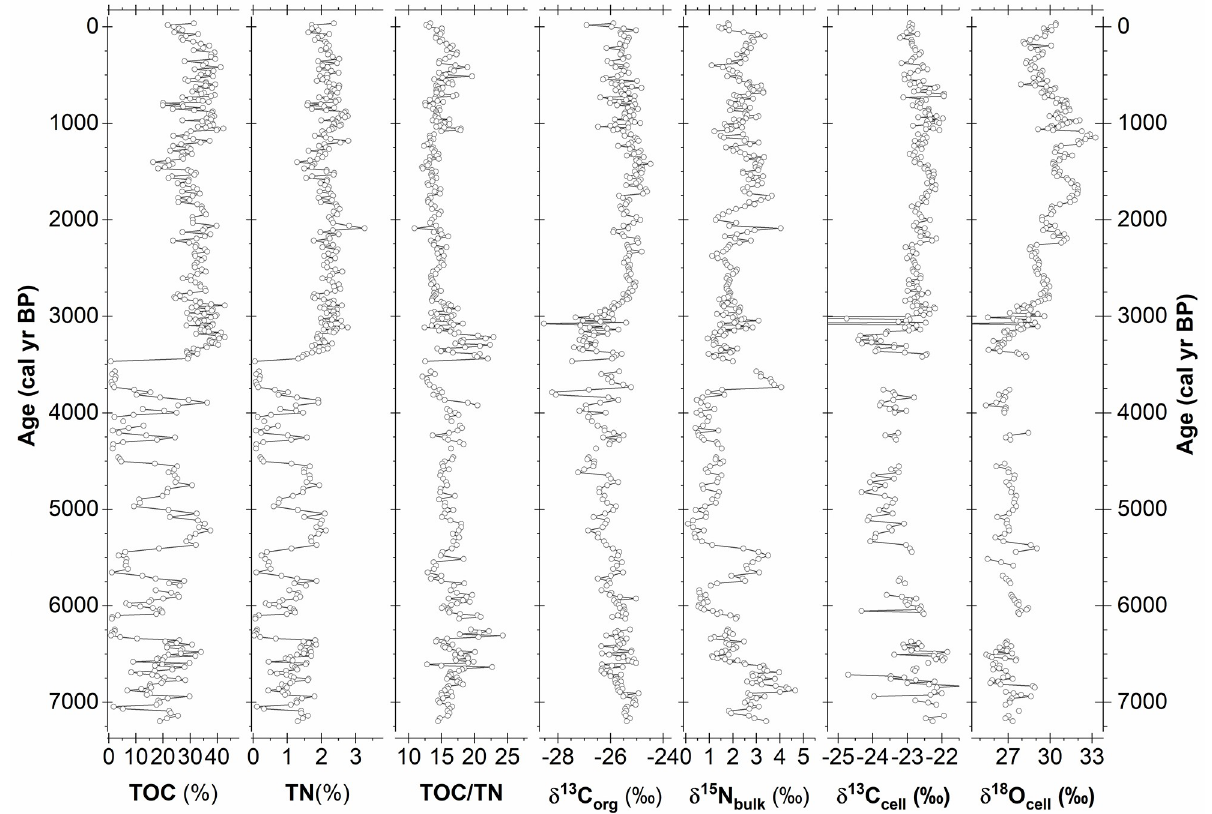
Fig 4. Element contents and stable isotope data of the CTP composite profile. Shown are the total organic carbon content (TOC), total nitrogen content (TN), the TOC to TN ratio (TOC/TN), the stable isotope composition of total organic carbon ( δ 13 C org ), the stable isotope composition of total nitrogen ( δ 15 N bulk ), the stable carbon isotope composition of cellulose ( δ 13 C cell ) and the stable oxygen isotope composition of cellulose ( δ 18 O cell